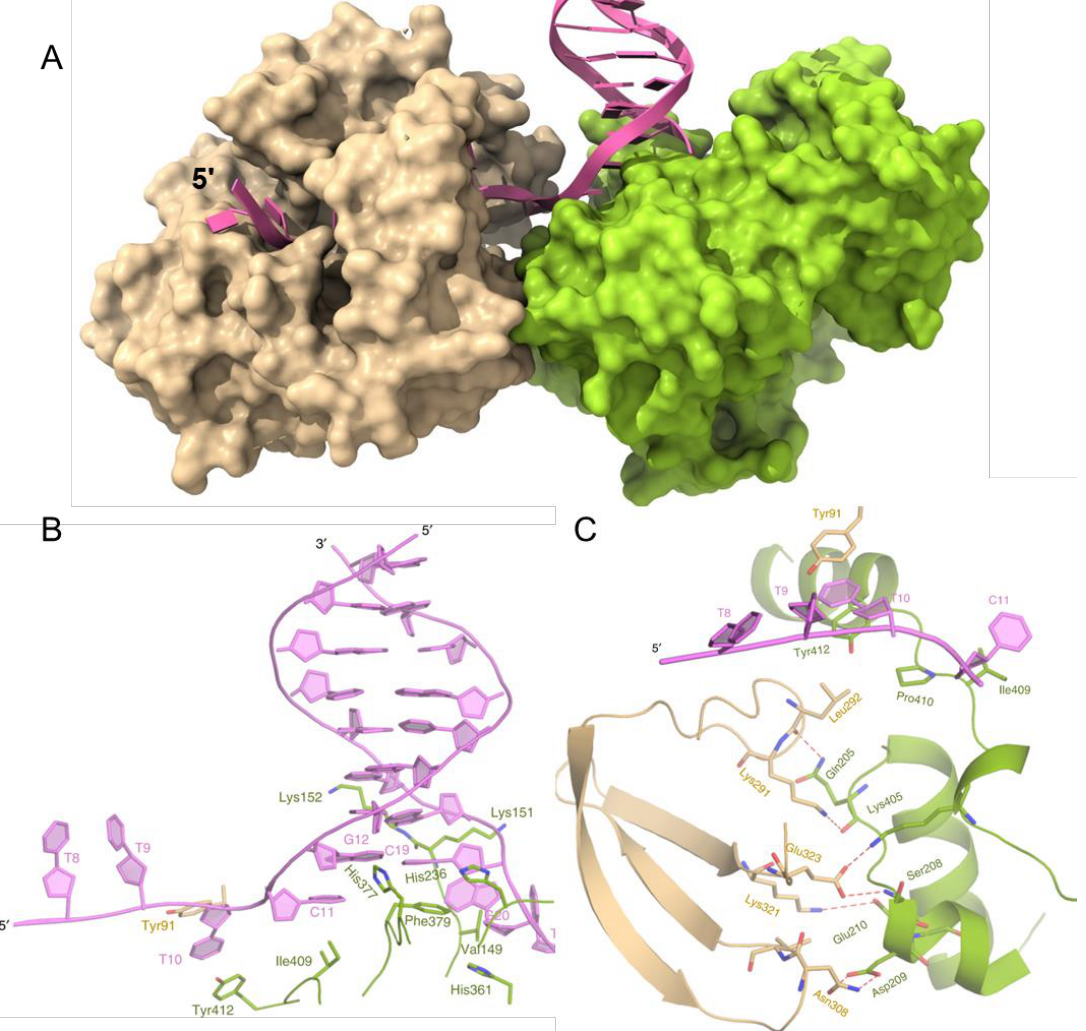
Figure 2. Structure of BaPif1 bound to a forked DNA. ( A ) Two molecules of BaPif1 (tan and green) are bound to the DNA fork (magenta). ( B ) The BaPif1 on the 3′-arm of the fork (green) is bound at the junction. ( C ) The two BaPif1 molecules interact. PDB ID 6L3G. Images reproduced from reference [26] Creative Commons CC